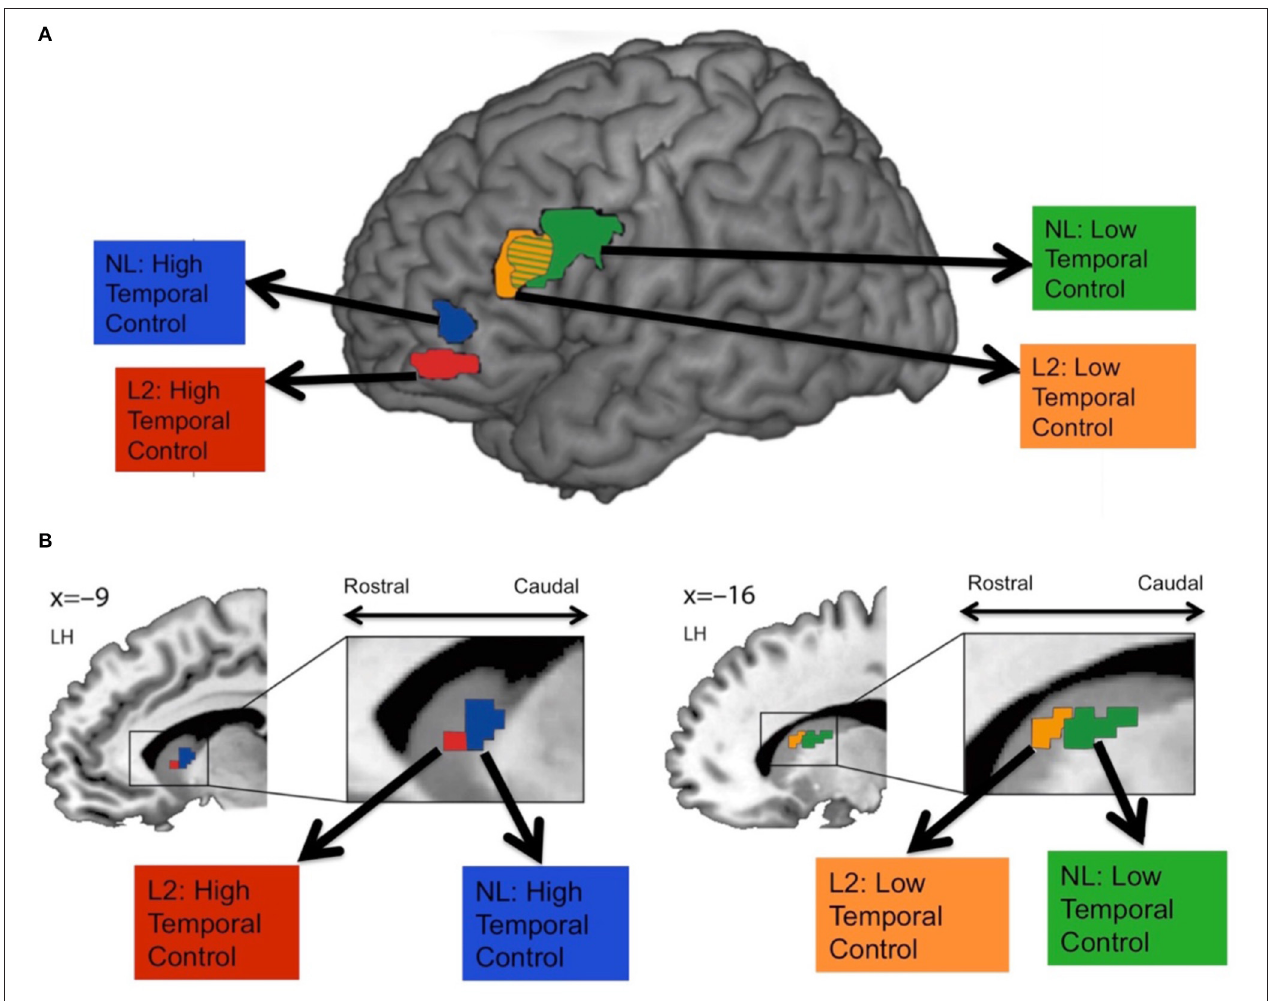
FIGURE 3 | Frontal (A) and striatal (B) activity during high vs. low temporal control tasks. Participants performed judgments on second language (L2) or a non-existing language (NL) phrases that were temporally close (low temporal control) or temporally more distinct (high temporal control). High temporal control activated more rostral fronto-striatal areas, whereas low temporal control activated more caudal fronto-striatal areas. Figure adapted with permission from the